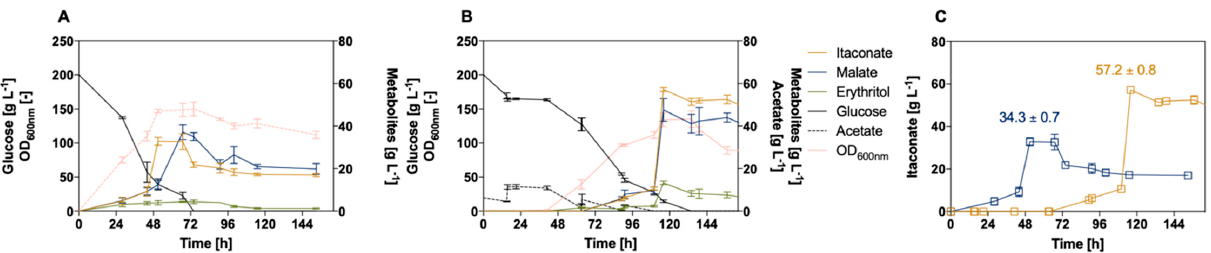
Figure 7 . Controlled-batch fermentations of U. maydis #2229 increasing glucose concentration to 200 g L − 1 . ( A ) Bioreactor experiments using 200 g L − 1 glucose, ( B ) with 200 g L − 1 glucose and 25 g L − 1 acetate. Cultivations were performed in MTM medium (0.8 g L − 1 NH 4 Cl, 30 °C, 80% DOT, at pH 6.5). ( C ) Overview of itaconate production of both experiments. Cultivations using acetate as a co-substrate are shown in orange (Y P/S = 0.25 ± 0.00 [g ITA /g c-source ]), and respective glucose references are shown in blue (Y P/S = 0.17 ± 0.00 [g ITA /g c-source ]). Error bars indicate the standard error of the mean ( n = 3). Those cultivations led to an itaconate titer of 57.2 ± 0.8 g L − 1 in the presence of the co-